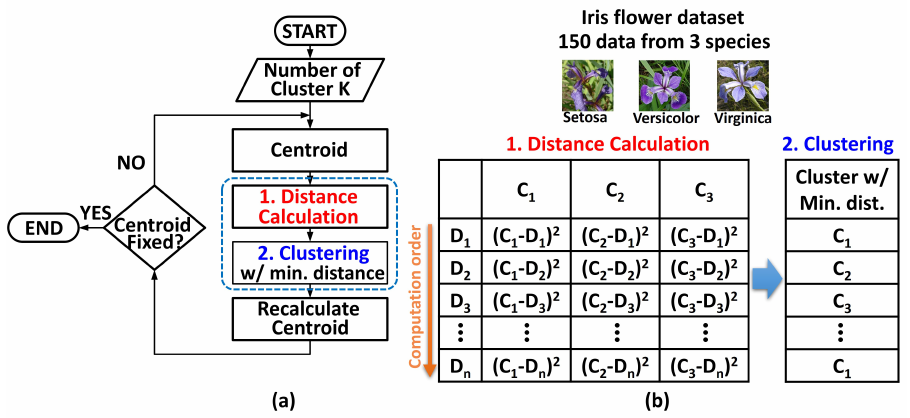
Figure 6. ( a ) Flowchart of the K-means clustering algorithm; ( b ) distance table generated for each iteration of the clustering